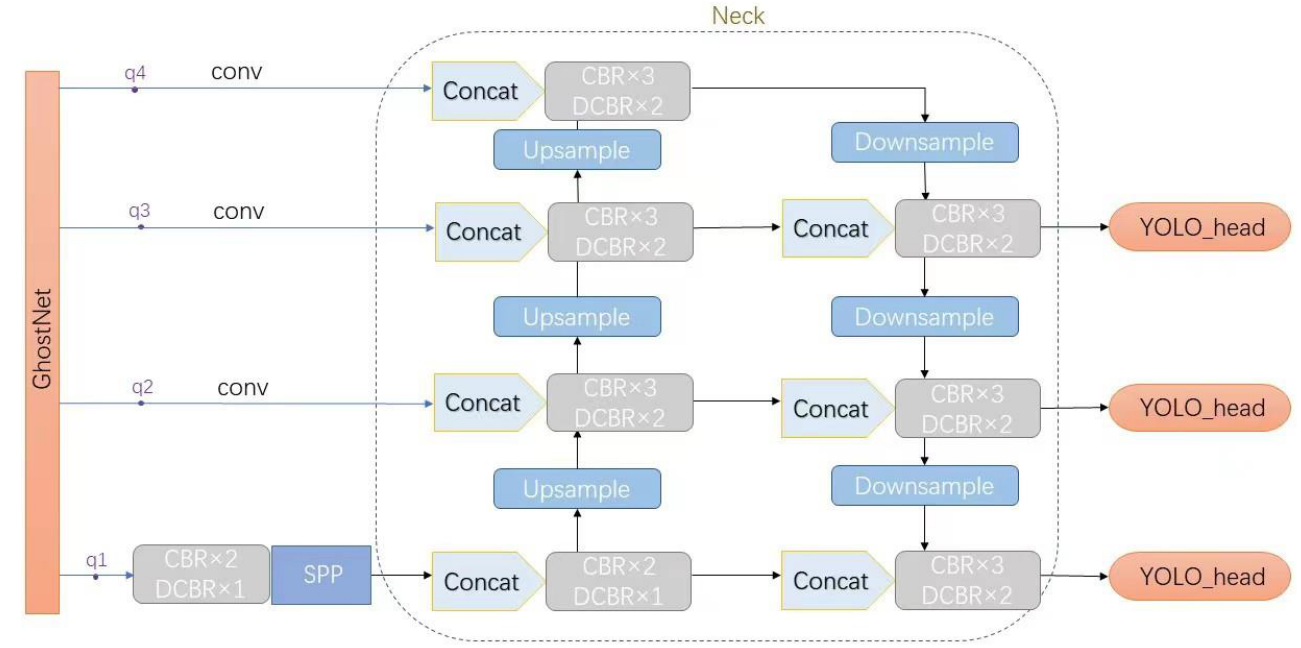
Figure 7. The framework of the improved YoloV4 network model. Note: Conv is convolutional, BN stands for Batch Norm, and CBR represents Conv + Batch Norm(BN) + Leaky relu activation function synthesis module, CBR means Conv + Batch Norm (BN) + Leaky relu activation function synthesis module, Depthwise Convolution plus Batch normalization plus Leaky relu activation function synthesis module, SPP stands for spatial pyramid